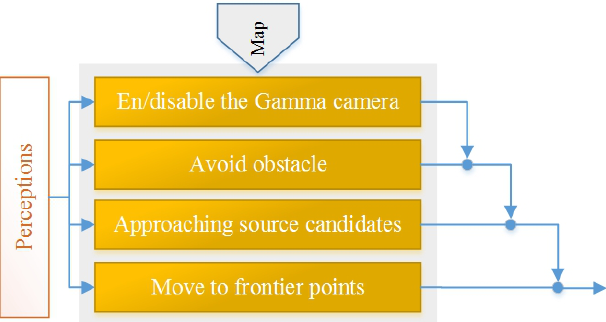
Figure 1. The control architecture for the behaviour-based system that performs exploration with limited